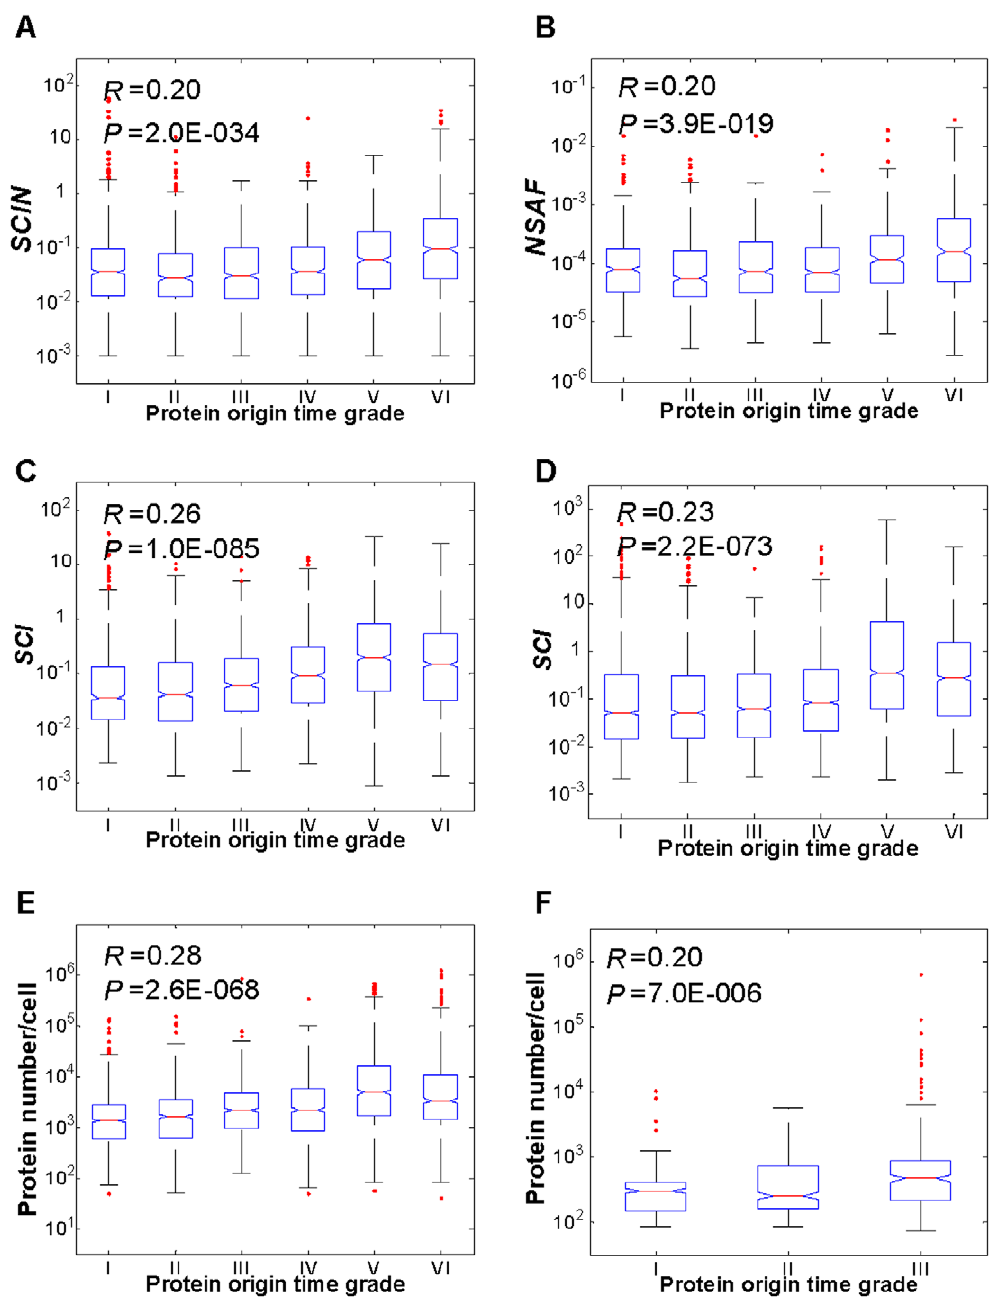
Figure 1. Proteome-wide correlation of proteins’ abundance with their origin time across six species. The relationship between origin time and abundance of proteins in H. sapiens ( A ), M. musculus ( B ), D. melanogaster ( C ), C. elegans ( D ), S. cerevisiae ( E ), and E. coli ( F ) were analyzed by Spearman rank correlation method. Protein origin time are categorized according to the data in OrthoMCL database. For (A)–(E), I, , 1 Gya; II, 1– 1.58 Gya; III, 1.58–1.84 Gya; IV, 1.84–2.23 Gya; V, 2.23–4 Gya; VI, . 4 Gya. For (F), I, , 2.6 Gya; II, 2.6–4 Gya; III, . 4 Gya. R represents Spearman rank correlation coefficient and P represents its P -value. The values of upper and lower quartile are indicated as upper and lower edges of the box, and the values of median are indicated as a red bar in the box. The maximum whisker length is set as 1.5, which means points are drawn as outliers (dotted individually outside the bars) if they are larger than q3 + 1.5 6 (q3 2 q1) (shown as the upper bar) or smaller than q1 2 1.5 6 (q3 2 q1) (shown as the lower bar), where q1 and q3 are the 25th and 75th percentiles respectively. ( SCIN : Spectral Count Index Normalized (11); SCI : Spectral Count Index (11); NSAF : Normalized Spectral Abundance Factor (12)). doi:10.1371/journal.pone.0032423.g001 coli , the statistic data was not powerful in case that the homologous proteins were too little in the OrthoMCL database, which may partly lead to the low correlation between conservation degree ( E. coli vs. mouse) and protein abundance (Fig. 2, B1 and F4).